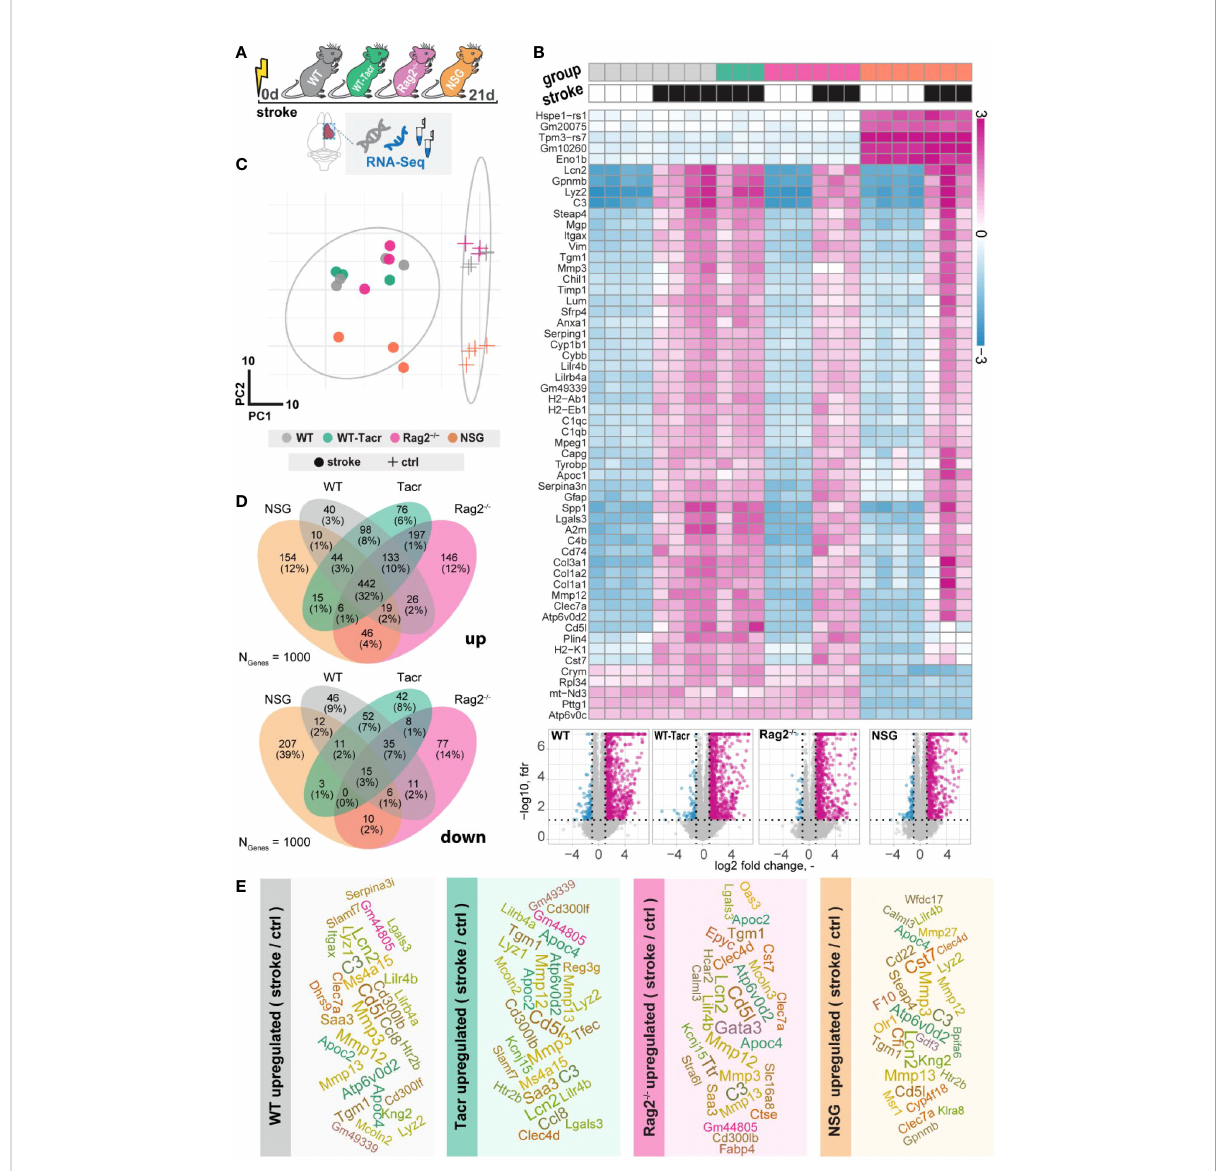
FIGURE 4 Gene expression changes in immunode fi cient mouse models after stroke. (A) Schematic overview of experimental time course and groups of mice: C57BL/6J wildtype (WT), tacrolimus immunosuppressed wildtype (WT-Tacr), recombination activating gene 2 de fi cient mice (Rag2 – / – ) and NOD scid gamma mice (NSG). (B) Heatmap of most differentially expressed genes and volcano plot of stroked (black boxes) to non-stroked (white boxes) WT, WT-Tacr, Rag2 -/- , NSG mice. (C) Principal component analysis, circles indicate stroked mice, crosses indicate non-stroked mice. (D) Venn diagram of common and differentially expressed top1000 genes in all groups of immunode fi cient mice. (E) List of top 30 upregulated genes after stroke in the respective group of immunode fi cient mice, font size represents strength of